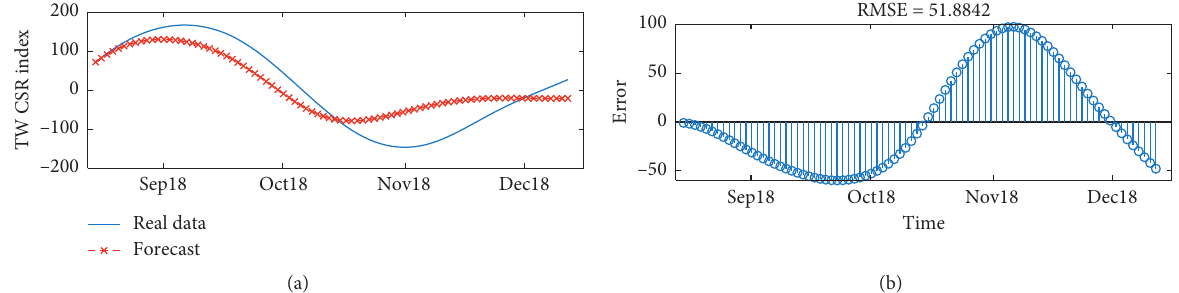
Figure 16: LSTM prediction and actual verification results for IMF4 with RMSE of